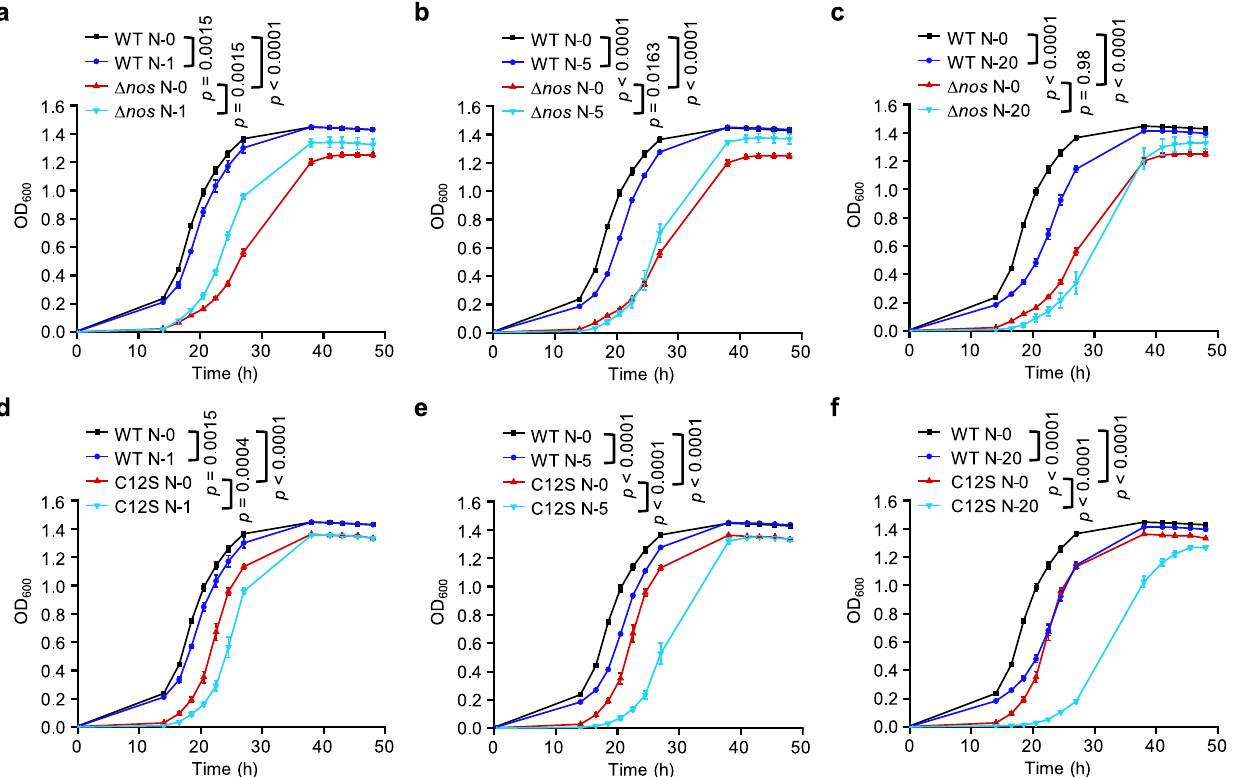
Fig. 3 | NO is required for S-nitrosylation on MgrA to facilitate vancomycin resistance. The WT and Δ nos strains ( a – c ) or the WT and mgrA C12S strains ( d – f ) weregrowninMHIImediumcontaining2 μ g/mLvancomycinin96-wellplateswith shaking at 200rpm for48h at37°C. OD 600 wasmonitored to evaluate the growth